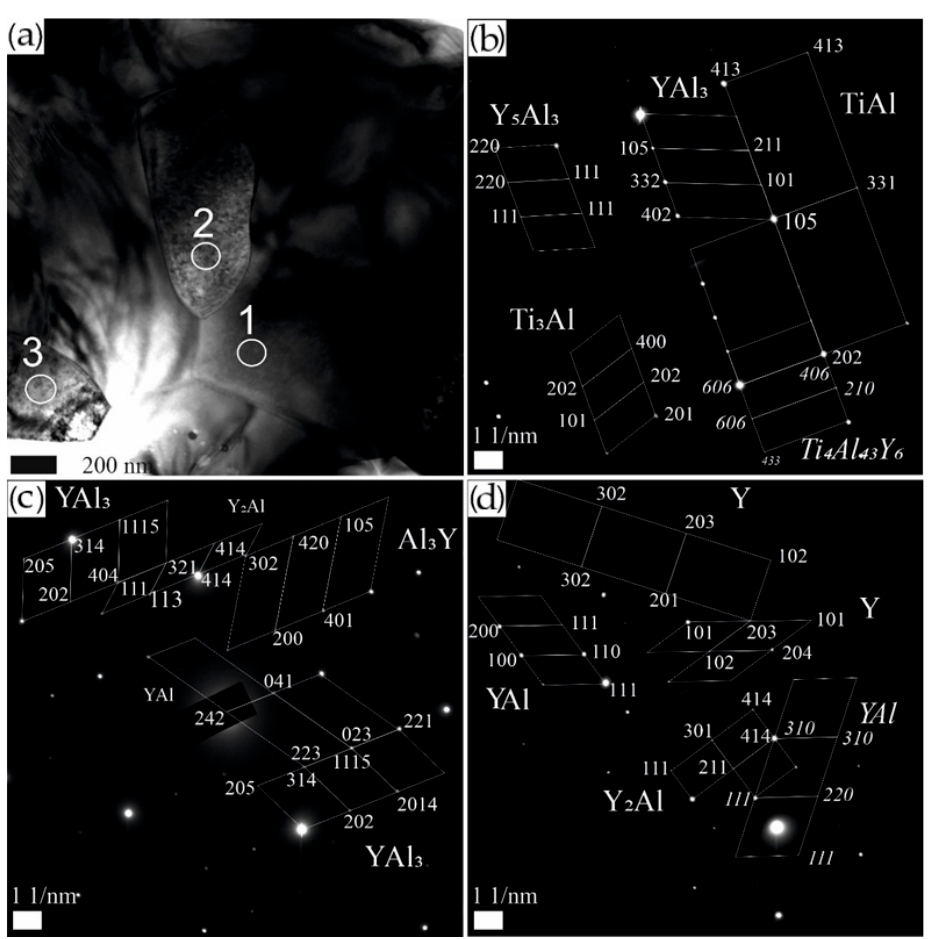
Figure 7. TEM image of the Ti-Al-Y alloy ( a ) SAED patterns of the Ti-Al-Y alloy in the relevant region ( b – d ).